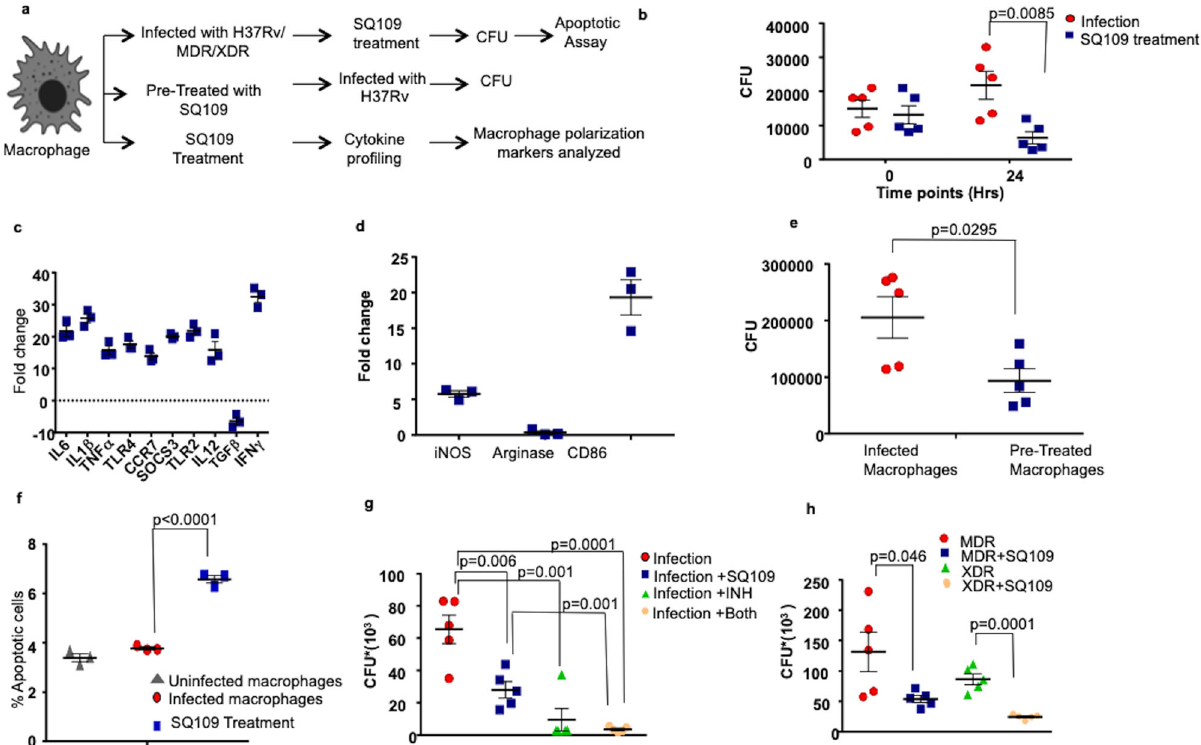
Fig. 3 SQ109 treatment polarizes macrophages towards a protective M1-type. a Experimental layout: (i) Peritoneal macrophages were infected with different strains of M.tb followed by SQ109 treatment. After 24 and 48 h of treatment, cells were harvested for CFU determination and apoptotic assay. (ii) Macrophages were pre-treated with SQ109 (0.39 μ g/ml) for 24 h, then washed, followed by H37Rv infection. At 24 h after infection, cells were harvested for CFU determination. (iii) Macrophages were treated with SQ109 followed by pro fi ling of cytokines and macrophage-polarizing markers at 12 h and 24 h of treatment. b CFU data showing bacterial survival in macrophages infected with H37Rv and treated with SQ109 (0.39 ug/ml). c , d RT-PCR data showing fold-changes in the expression of cytokines and macrophage polarizing markers in SQ109-treated macrophages compared to control macrophages. e CFU data showing bacterial survival in macrophages pre-treated with SQ109. f Annexin V and Propidium Iodide FACS analysis of macrophages infected with H37Rv followed by SQ109 treatment. g CFU data showing bacterial survival in macrophages infected with H37Rv and treated with SQ109 (0.39 μ g/ml) and Isoniazid. h CFU data showing bacterial load in macrophages infected with MDR & XDR strains of M.tb and treated with SQ109 (0.78 μ g/ml). n = 3 biological replicates were used for three independent experiments. Statistical signi fi cance was tested using multiple/unpaired t -test unless speci fi ed